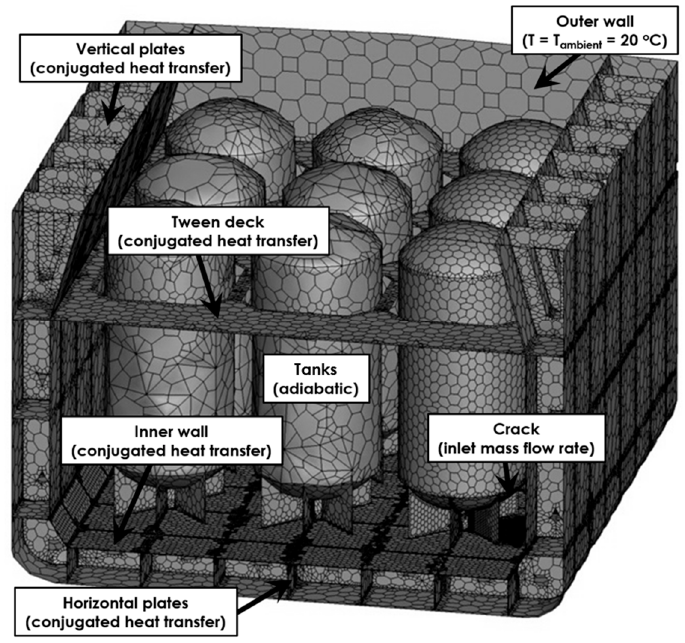
Figure 3. Grid system and boundary conditions for CO 2 cargo room.